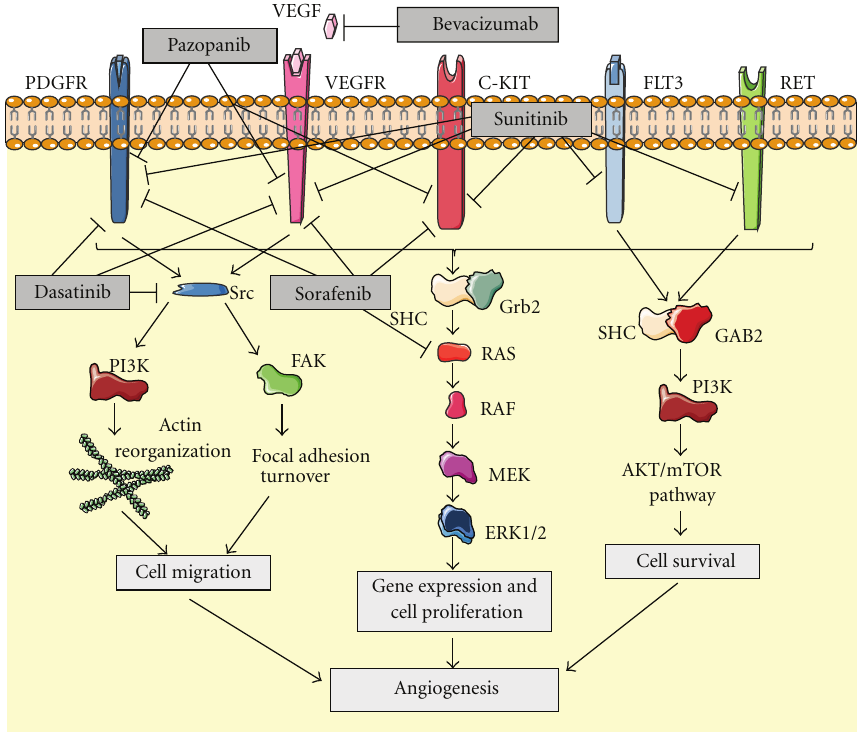
Figure 1: Inhibition of angiogenesis by blocking di ff erent tumorigenic signaling